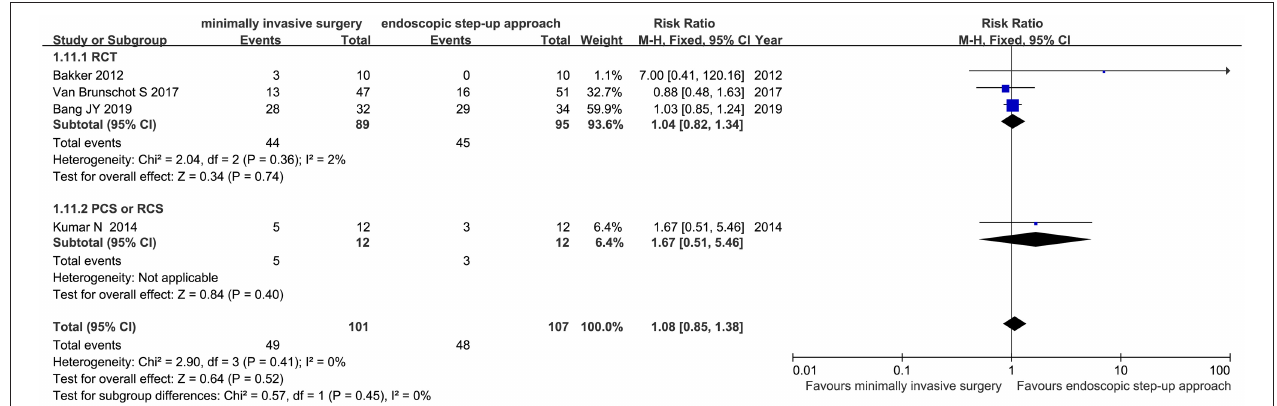
FIGURE 12 | Forest plots for the incidence of exocrine pancreatic insufficiency after minimally invasive surgery and endoscopic step-up approach. M-H, Mantel–Haenszel test; Fixed, a fixed effects model; CI, confidence